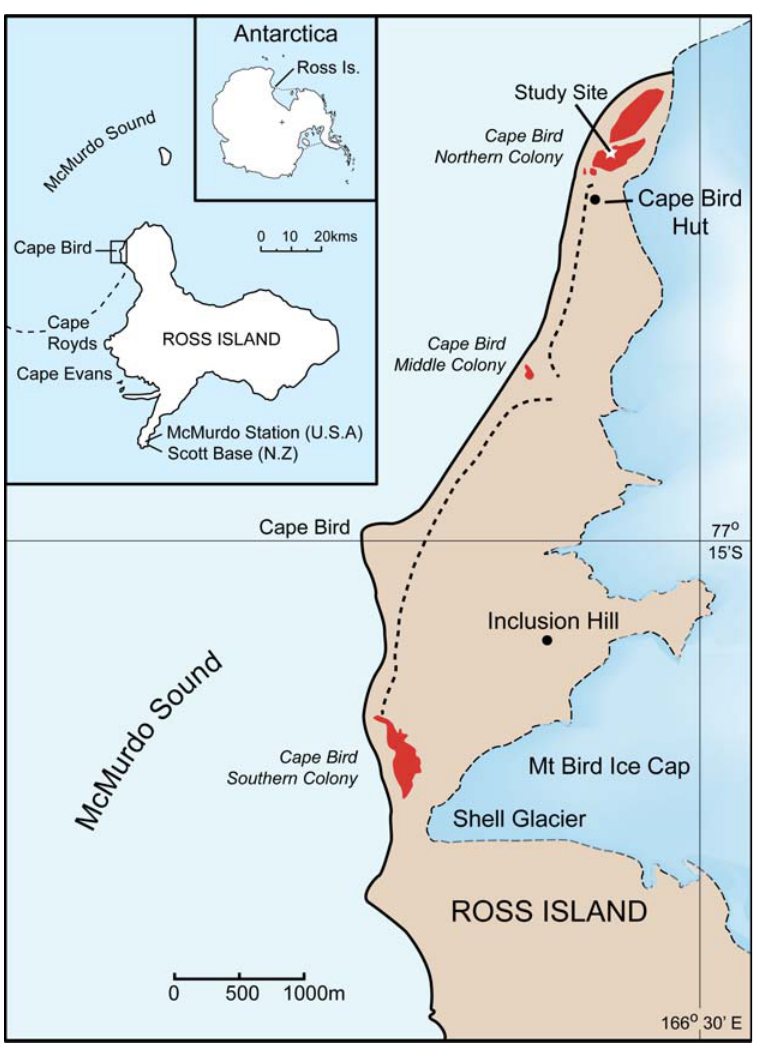
Figure 4. Location of the study site at Cape Bird, Ross Island, Antarctica.